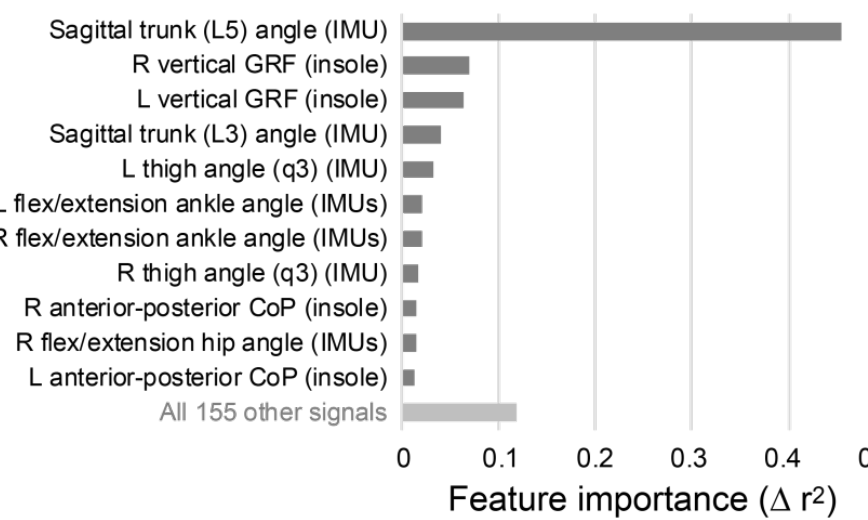
Figure 5. Sagittal trunk angle and vertical GRFs are the most important signals for estimating lumbar moments, consistent with the findings from idealized wearable sensor analysis in Figure 3. Signal importances here are from the real wearable sensor algorithm for estimating lumbar extension moments. R = right; L = left.